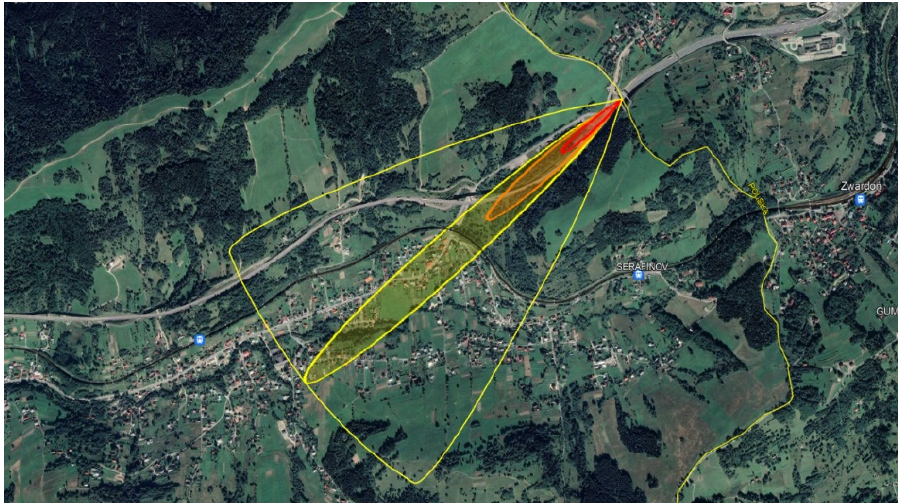
Figure 8. Graphical representation of the dispersion of a dangerous substance at the Skalit é -Zwardo ň -Myto border crossing [24,25].